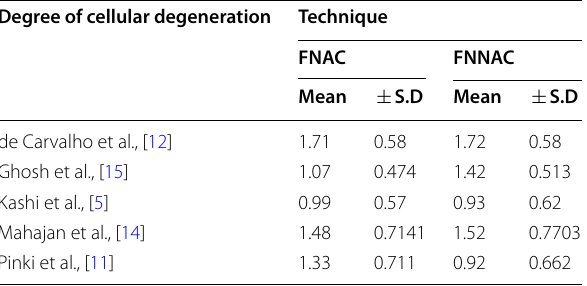
Table 11 Comparison between different studies regarding degree of cellular degeneration using FNAC vs FNNAC